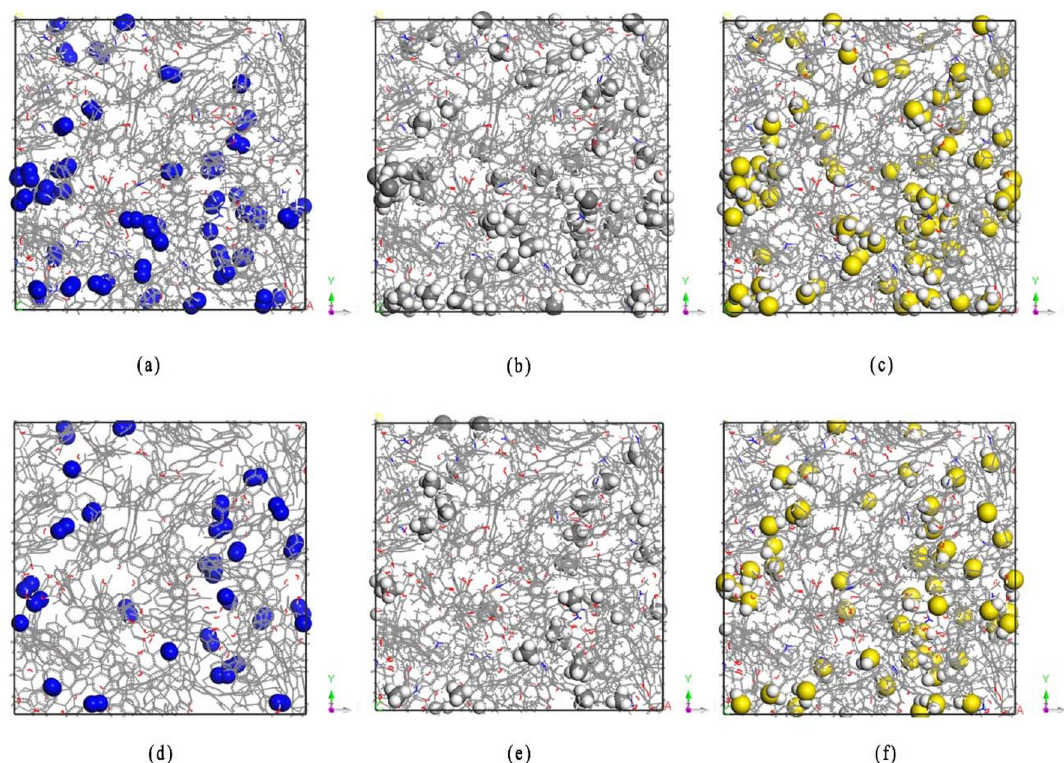
Figure 9. Density distribution of the gases, when content of water in coal is 1.18 or 4.51%. ( a ) N 2 ,1.18%, ( b )